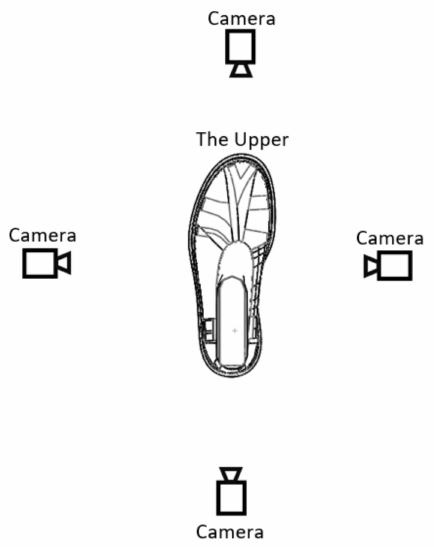
Figure 3. Placement of